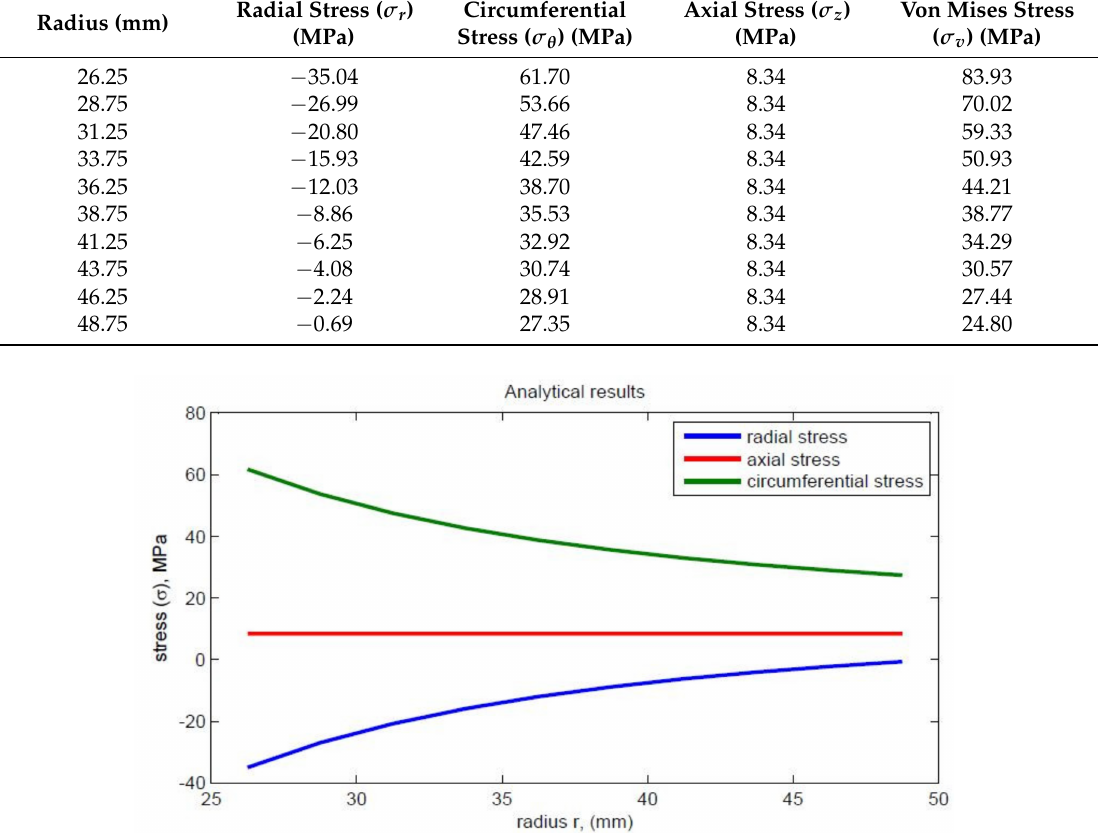
Figure 2. Variation of radial, circumferential, and axial